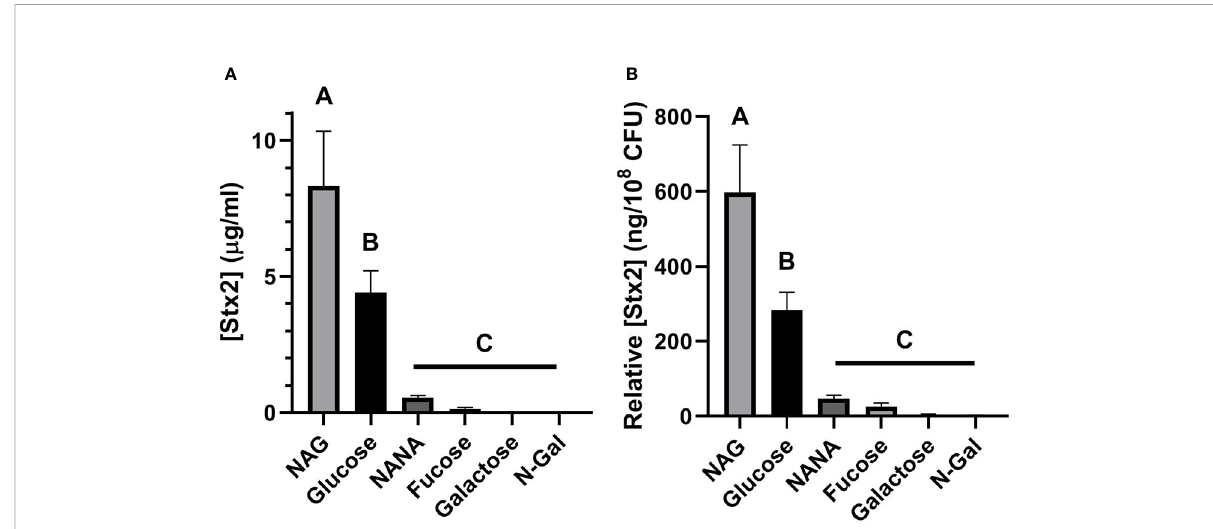
FIGURE 3 Production of Stx2 in the presence of mucus-derived sugars. E. coli O157:H7 cultures were grown in M9 +10 mM medium of mucus-derived metabolites (Fucose, Galactose, N-Gal. NANA or NAG) or Glucose at 37°C for 5 h under agitation. (A) [Stx2] in the fi ltered bacterial SN estimated from its cytotoxic activity in Vero cells. (B) [Stx2] relative to bacterial density, expressed as ng of Stx2 per 10 8 CFU present after the incubation period. Data are shown as mean ± SEM. Signi fi cant differences were found between groups with different letters (A. B and C) (p < 0.05, n =